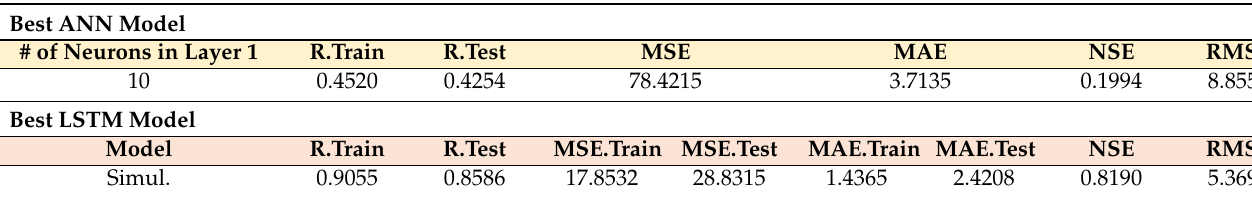
Table 1. Best LSTM and ANN models for prediction.